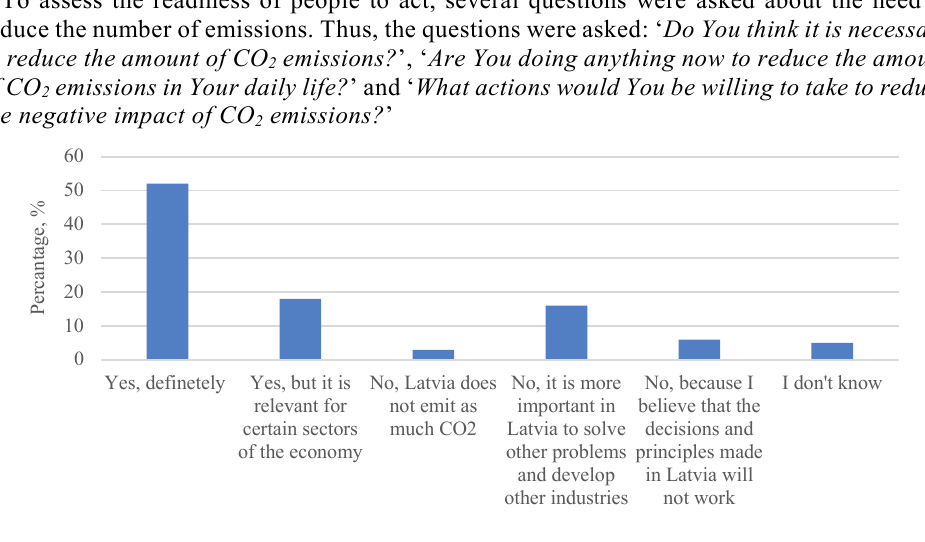
Fig. 7. The necessity to reduce CO 2 emissions on respondent’s